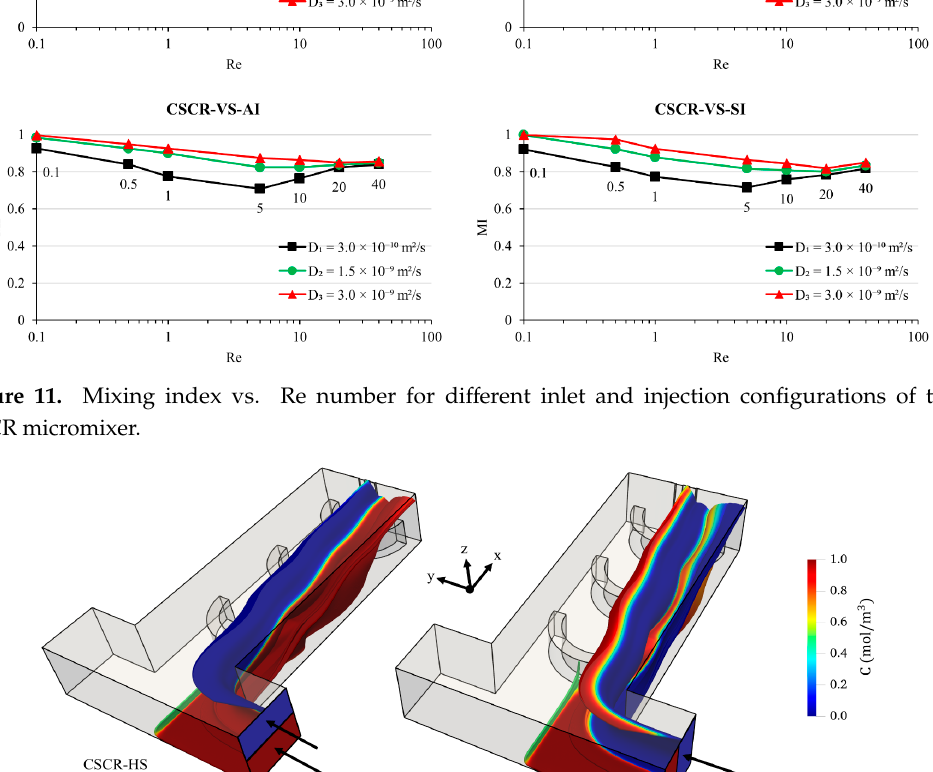
Figure 12. Utilization of rotational fluid flow depending on the splitting type (Re = 5 and D = D 1